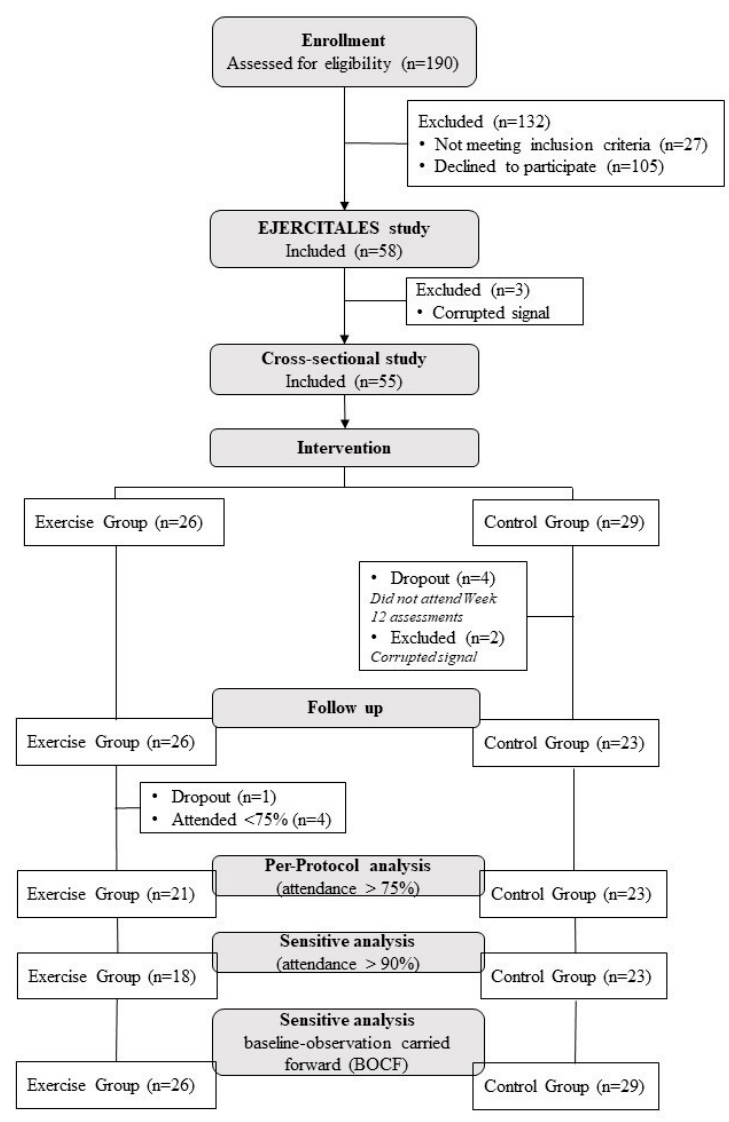
Figure 1. Flowchart of the study participants throughout the study.